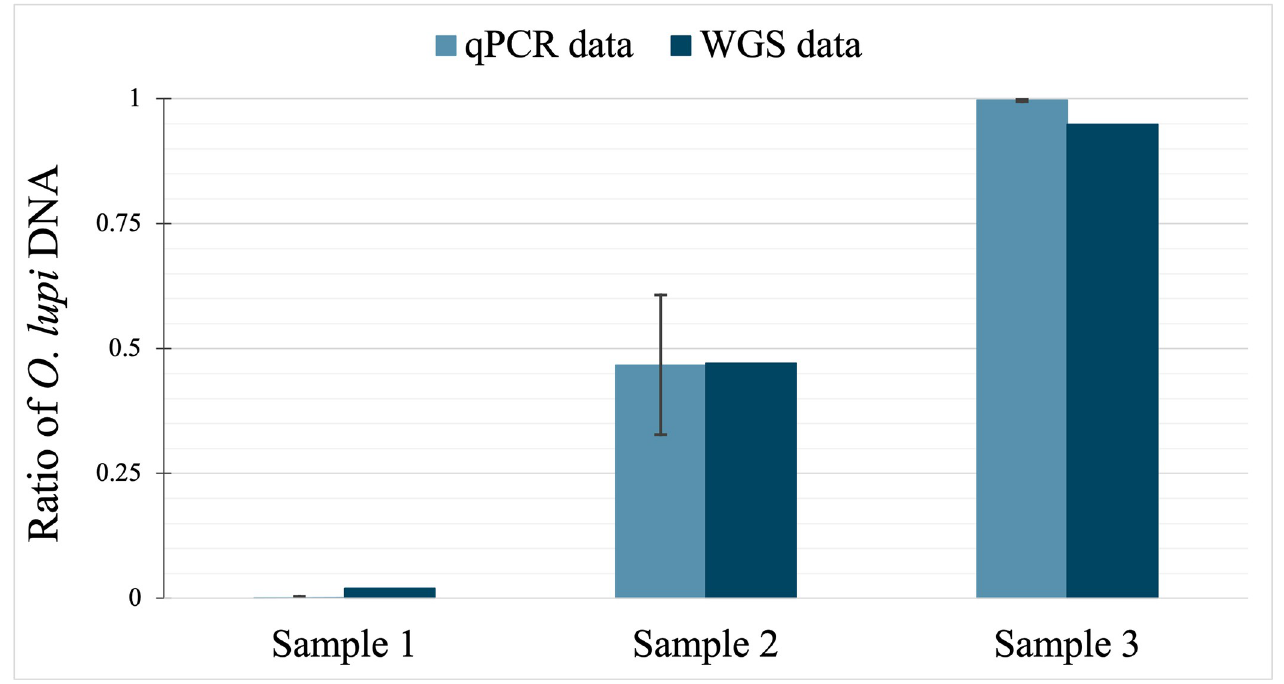
Fig 1. Comparison of Onchocerca lupi percentage from three biological canine samples. Samples were screened using LupiQuant which estimated O . lupi percentages within each sample. Whole genome sequences of O . lupi samples were aligned to O . lupi reference genome (BioProject PRJNA802584) to compare LupiQuant ratios. Error bars represent the range of O . lupi percentages based on host and parasite technical replicates.